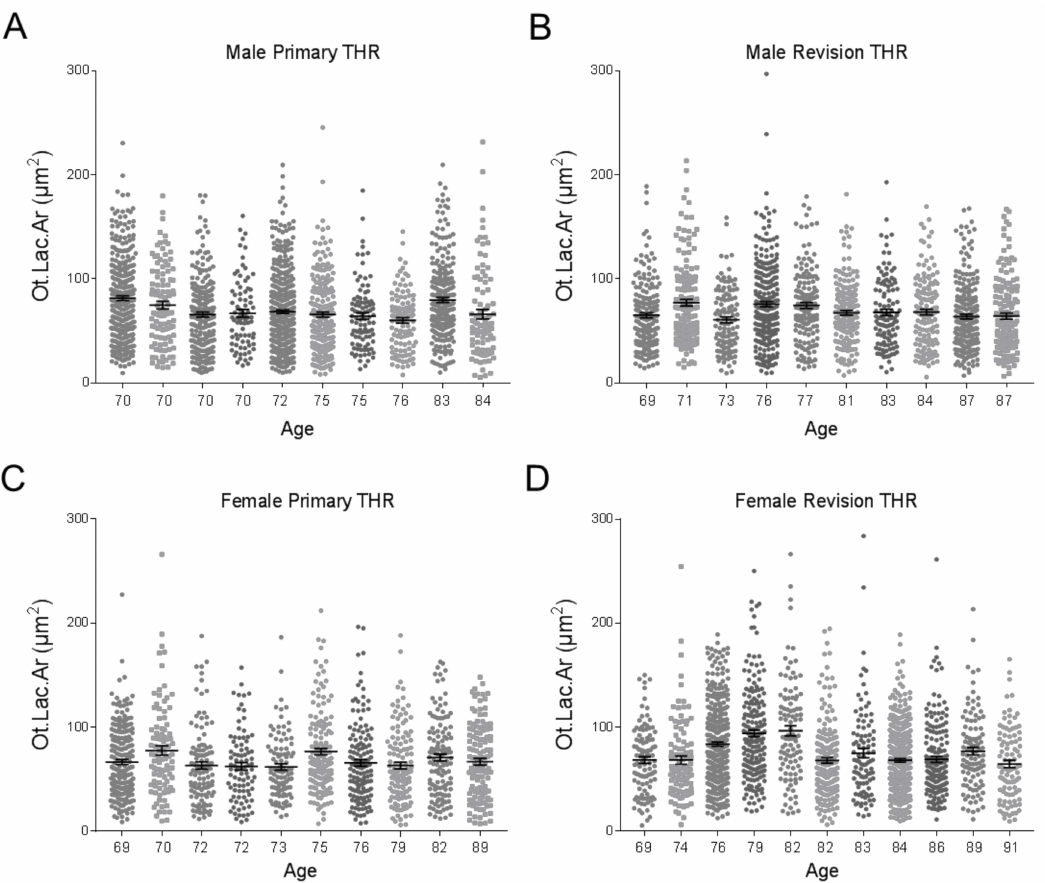
Figure 3. Column scatter plots of quantified osteocyte lacunar areas (Ot.Lac.Ar ( µ m 2 )) for each patient biopsy with corresponding patient age: ( A ) male Primary THR patient biopsies; ( B ) male Revision THR patient biopsies; ( C ) female Primary THR patient biopsies and ( D ) female Revision THR biopsies. THR: total hip